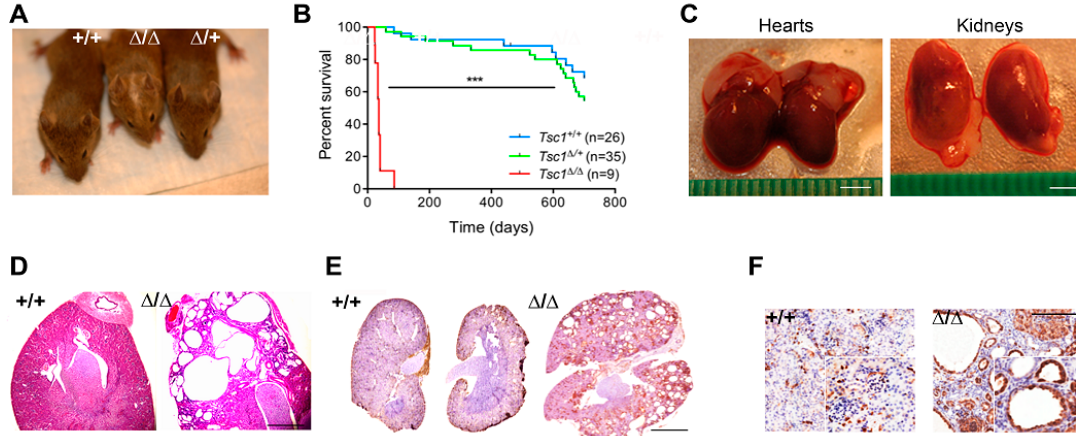
Figure 1. Tagln -mediated Tsc1 inactivation replicate features of human tuberous sclerosis. ( A ) Representative macroscopic pictures of Tsc1 +/+ , Tsc1 ∆ /+ , and Tsc1 ∆ / ∆ 28 day old littermates. Note the reduced size of Tsc1 ∆ / ∆ mouse (middle) and white hair on the head. ( B ) Survival curve for mice with the indicated genotypes as a function of days. A statistically significant decrease in lifespan was observed for Tsc1 ∆ / ∆ mice compared with Tsc1 ∆ /+ and Tsc1 +/+ cohorts (***, p < 0.001). ( C ) Hearts and kidneys from Tsc1 +/+ control and Tsc1 ∆ / ∆ knockout mice indicating a modest enlargement of both organs following Tsc1 inactivation. ( D ) Hematoxylin and eosin (H&E) staining of sections of kidneys isolated from 28 day old Tsc1 ∆ /+ and Tsc1 +/+ mice, revealing a spongiotic renal appearance and bilateral cystification following homozygous Tsc1 deletion ( ∆ / ∆ ). Scale bar: 1000 µ m. ( E ) pS6 staining (brown color) of Tsc1 +/+ and Tsc1 ∆ / ∆ kidneys indicating increased activation of mTOR following Tsc1 inactivation. Scale bar: 2000 µ m. ( F ) Higher magnification views showing localization of pS6 staining within lining cells of cystic lesions in Tsc1 ∆ / ∆ kidneys. Scale Bar: 250 µm.